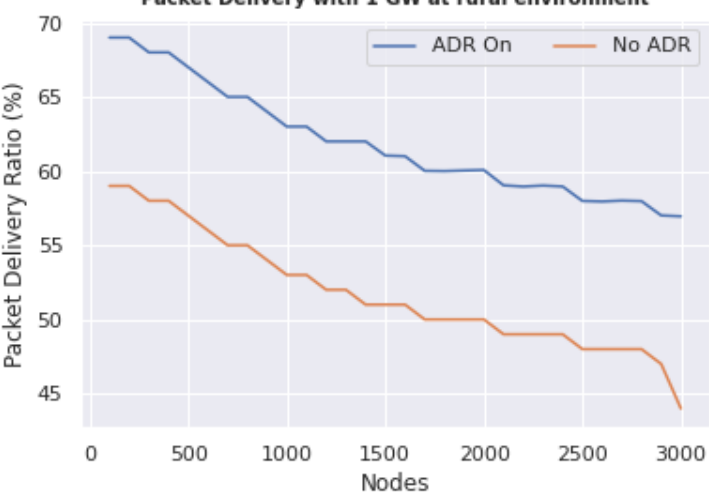
Figure 11. Packet delivery ratio to the network server with a single gateway under propagation conditions simulating a rural